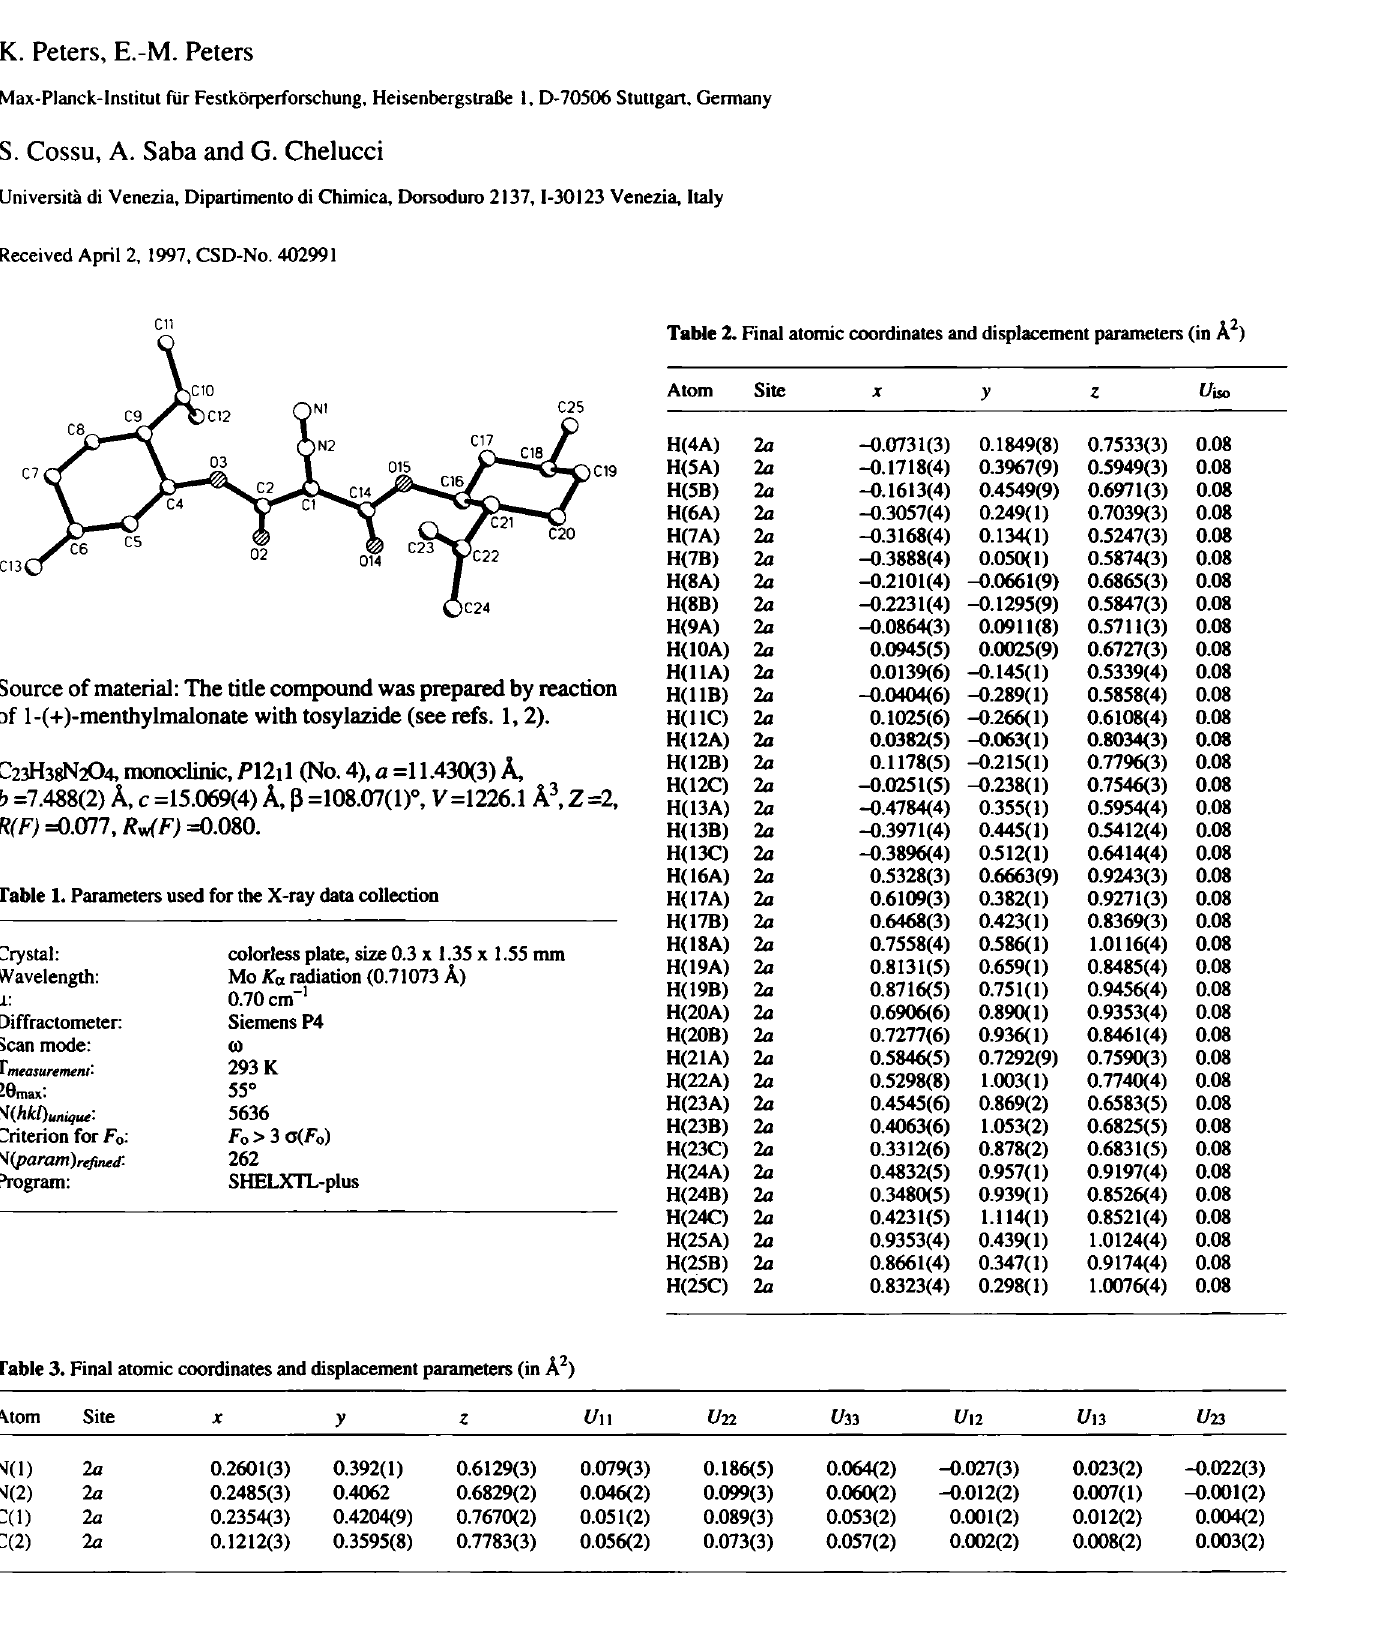
Table 2. Final atomic coordinates and displacement parameters (in Â^)